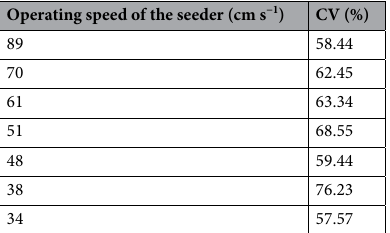
Operating speed of the seeder (cm s −1 )